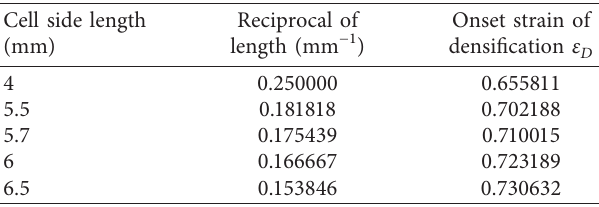
Table 2: Onset strain of densification under different cell side lengths.